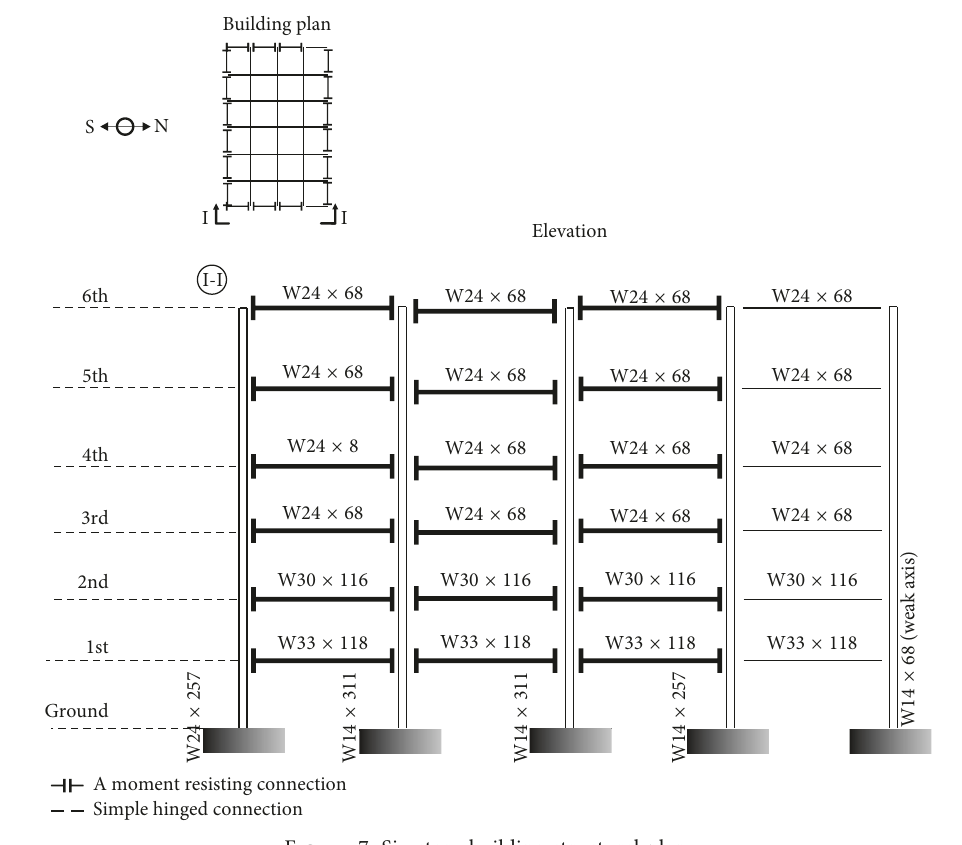
Figure 7: Six-story building structural N-S direction is the direction where fault normal component of the earthquake acts. The maximum dis- placement in N-S direction and maximum rotation of each story for Erzincan bidirectional ground motion is shown in Figure 8. Tendon controllers are assumed to be operating in the N-S direction; therefore, both methods are not effective in reducing the displacements in E-W direction. It should be noted here that the displacements in E-W direction are almost three times smaller than the ones in N-S direction. It